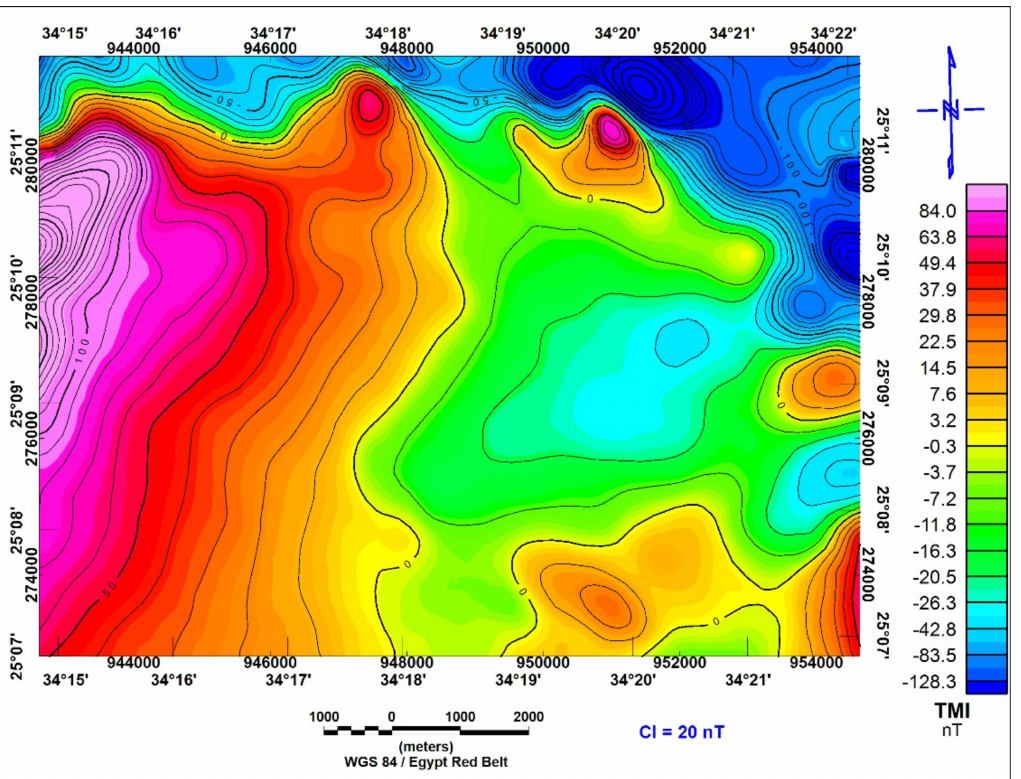
Figure 4. Total-airborne magnetic-field anomaly (TMA) map of Homrit Waggat area [21].